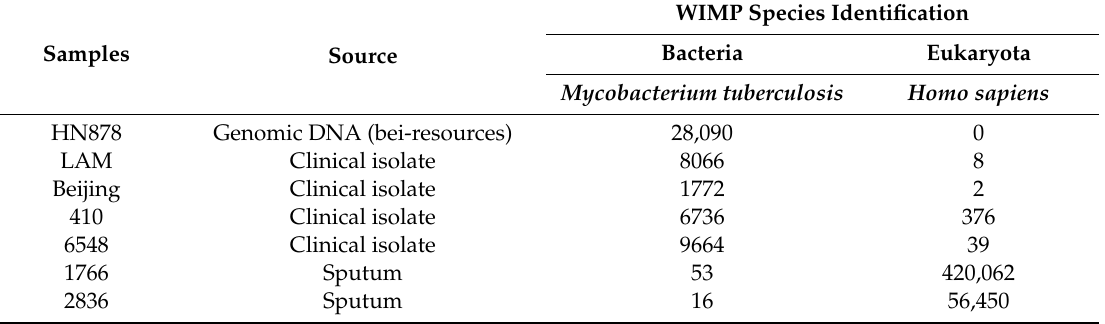
Table 1. Microbial identification through sequencing DNA analysis. LAM: Latin American and Mediterranean, WIMP: What’s In My Pot.